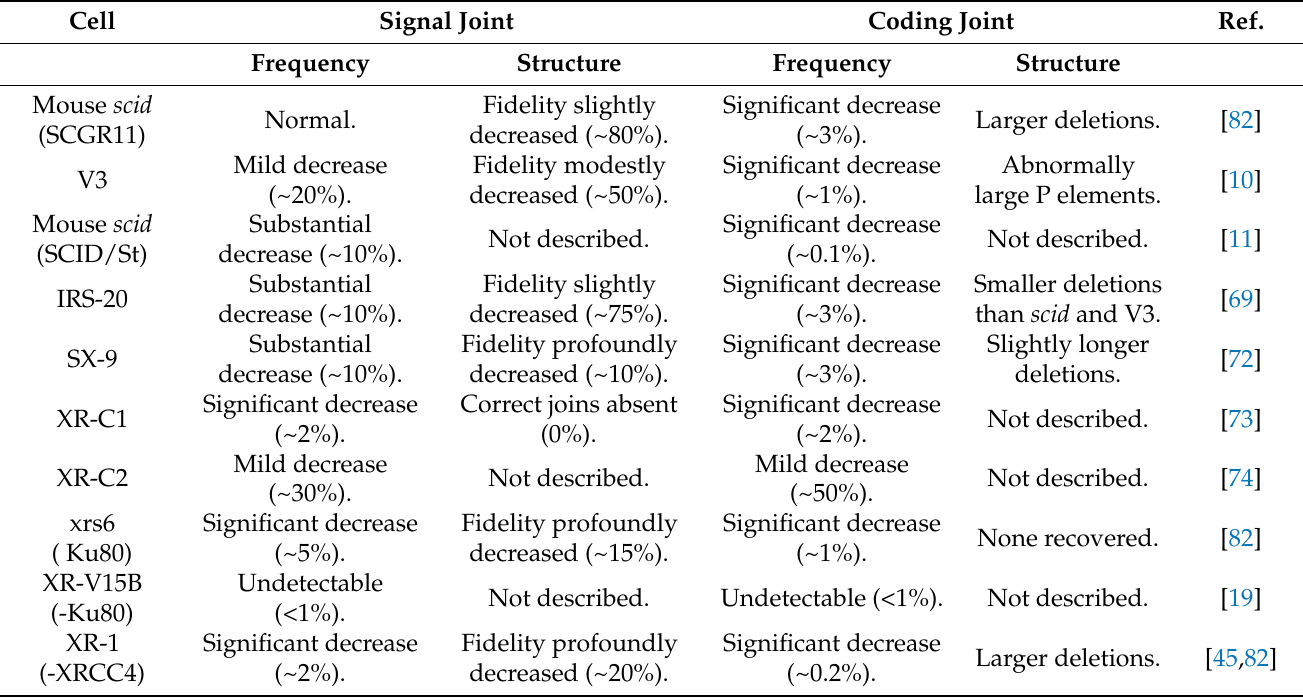
Table 2. V(D)J recombination defects in DNA-PKcs-deficient